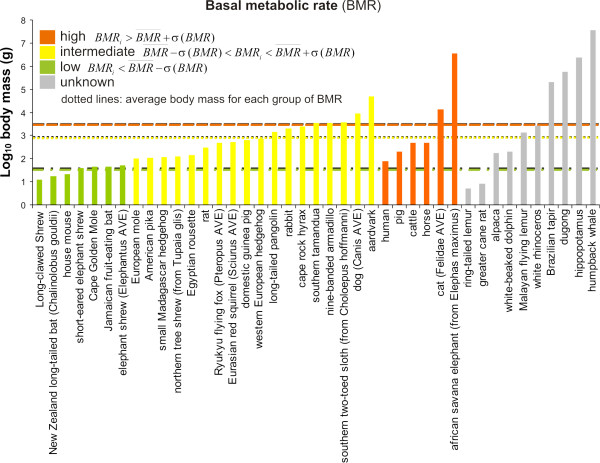
Basal metabolic rate vs log10 (body mass). The basal metabolic rate (BMR) is presented in three categories (low, intermediate and high). When the BMR value was not available for the species in study, either that of a close relative (indicated in parenthesis) or the average values of several closely related species (AVE) were used (together with the corresponding body mass value). The increase in BMR with the body mass can be easily observed by comparing the average values for each category (dotted lines).